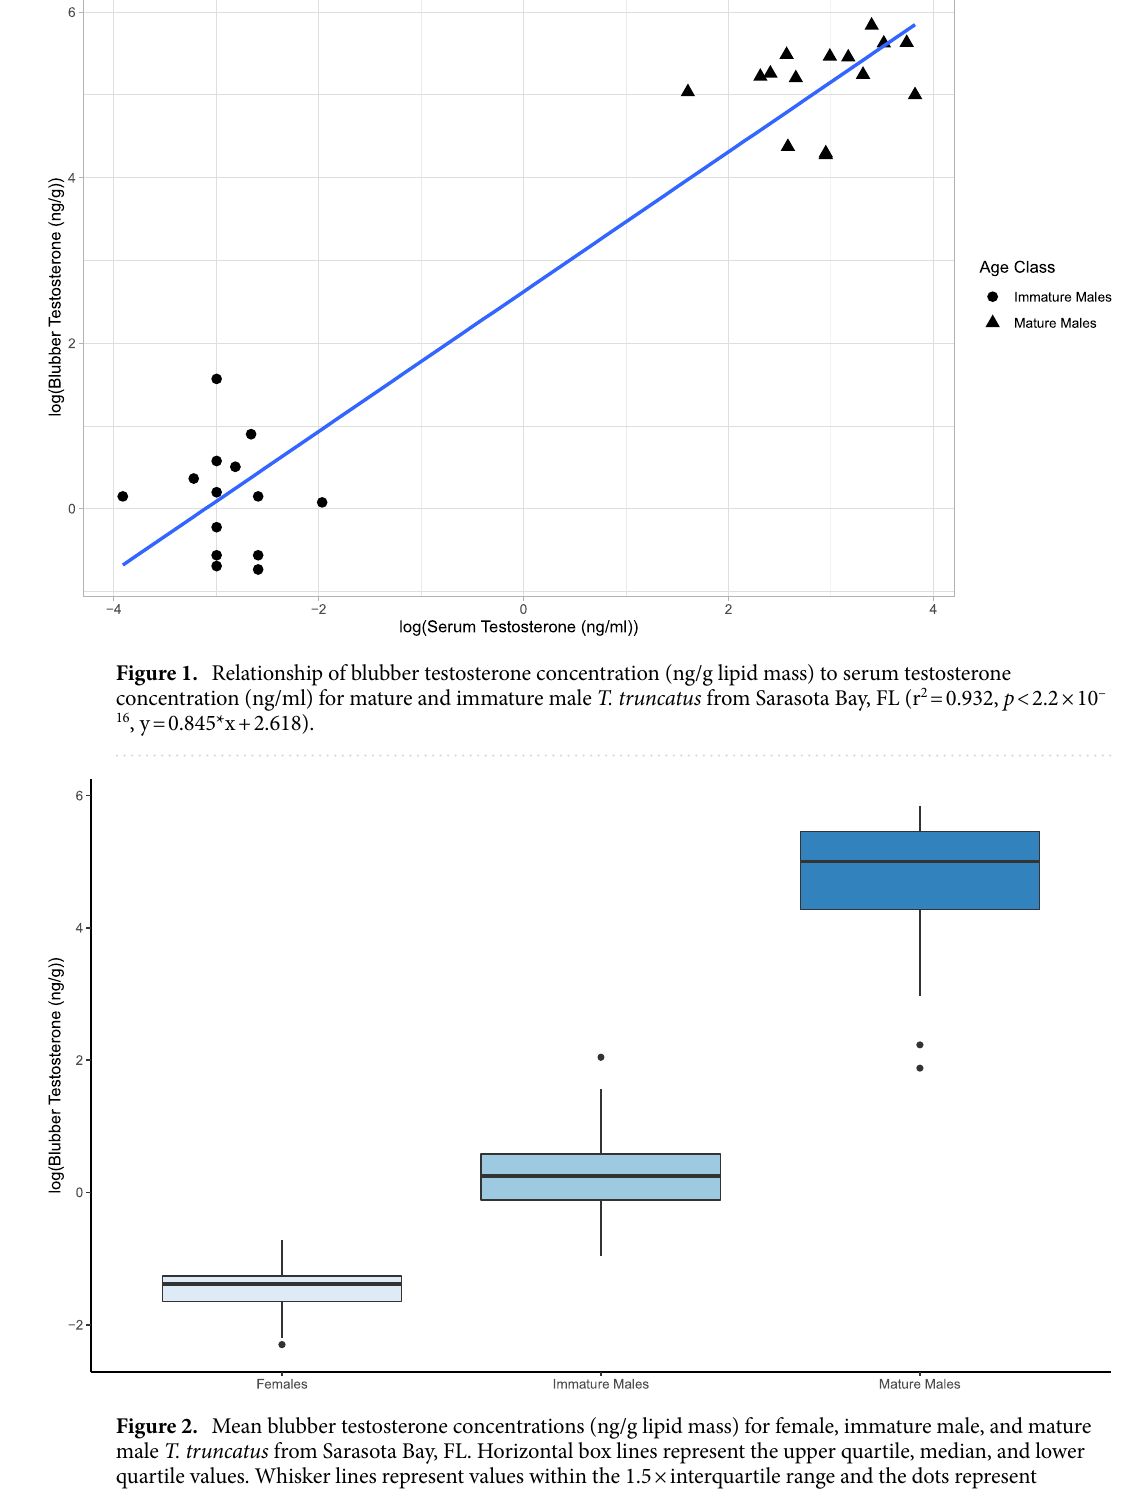
males (18.89 ± 1.48 SE cm 3 ).